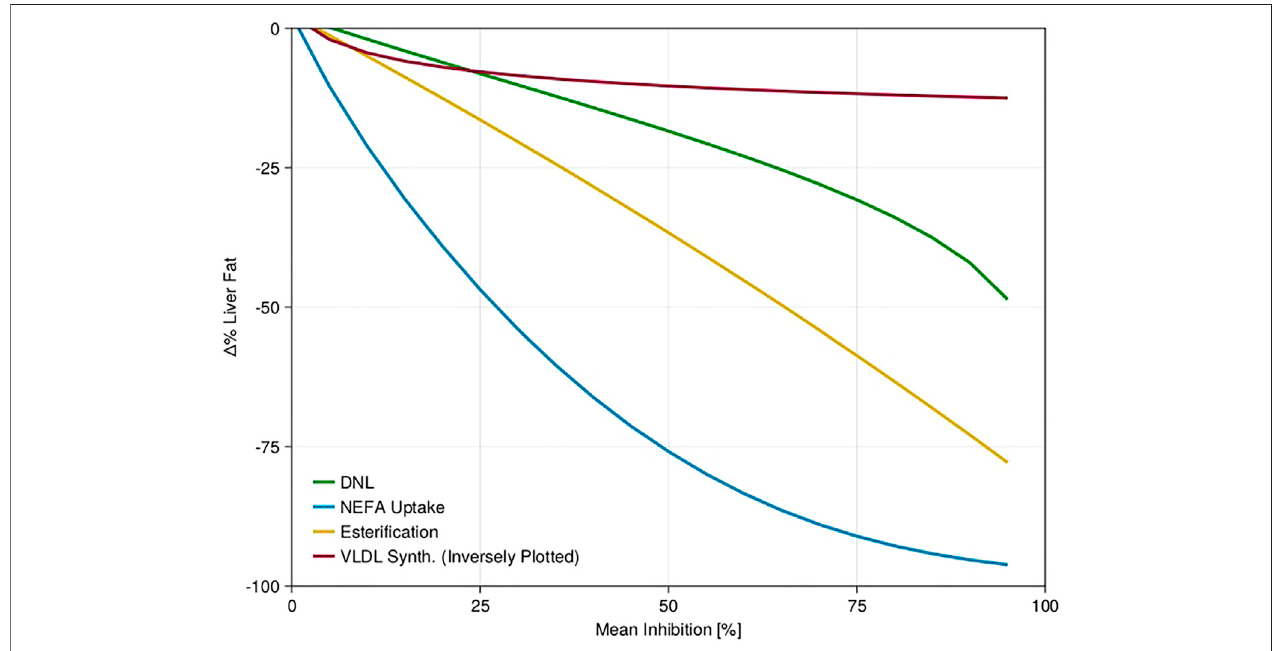
FIGURE5| SensitivityanalysisofmeanNAFLDvirtualpopulation response tostepchangesin fi vemodel fl uxes.Fluxeswerevaried asdescribedinthetextforfour different fl uxes.Three fl uxeswereinhibited,one fl ux(VLDLsynthesis)wasactivated.Fortheactivated fl uxweplotteditonthesamescaleastheotherthreebyplottingthe x-axis inversely. For clarity, only the mean response of the NAFLD virtual patients is shown.